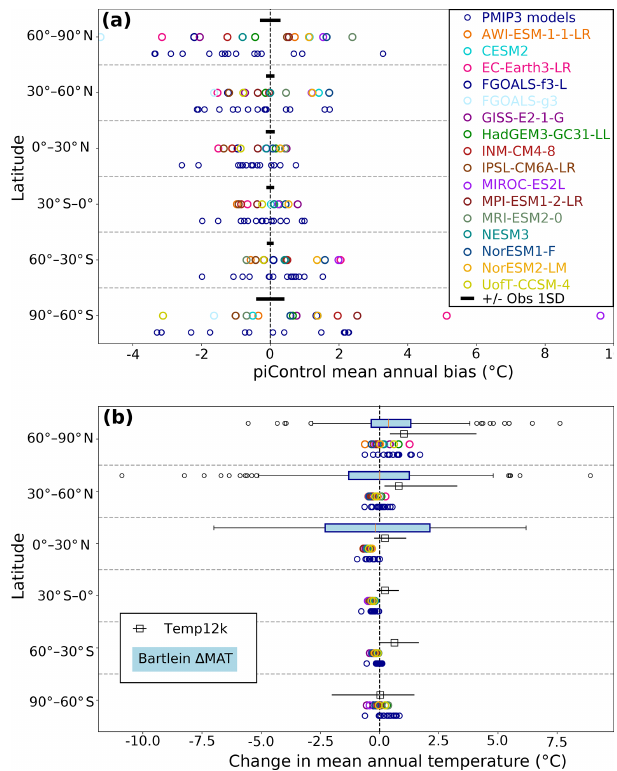
Figure 4. Zonal averaged temperatures within the PMIP4-CMIP6 ensemble. (a) Comparison of the piControl zonal mean temperature profile of individual climate models to the 1850–1900 observations. The area-averaged, annual mean surface air temperature for 30 ◦ lat- itude bands in the CMIP6 models (identified), CMIP5 models (blue circles), and a spatially complete compilation of instrumental ob- servations over 1850–1900 (black, Ilyas et al., 2017; Morice et al., 2012). (b) The simulated annual mean temperature change averaged over 30 ◦ zonal bands for each of the individual CMIP6 models. The equivalent changes estimated from the Temperature 12k com- pilation (Kaufman et al., 2020b) via a multi-method approach are shown along with their 80% confidence interval. The distribution of Bartlein et al. (2011) reconstructed temperatures within each lat- itude bands are shown in the NH, because the tropical and Southern Hemisphere latitudes are only represented by sites in Africa. The data points for all models, as well as the equivalents over land or ocean, are provided in the